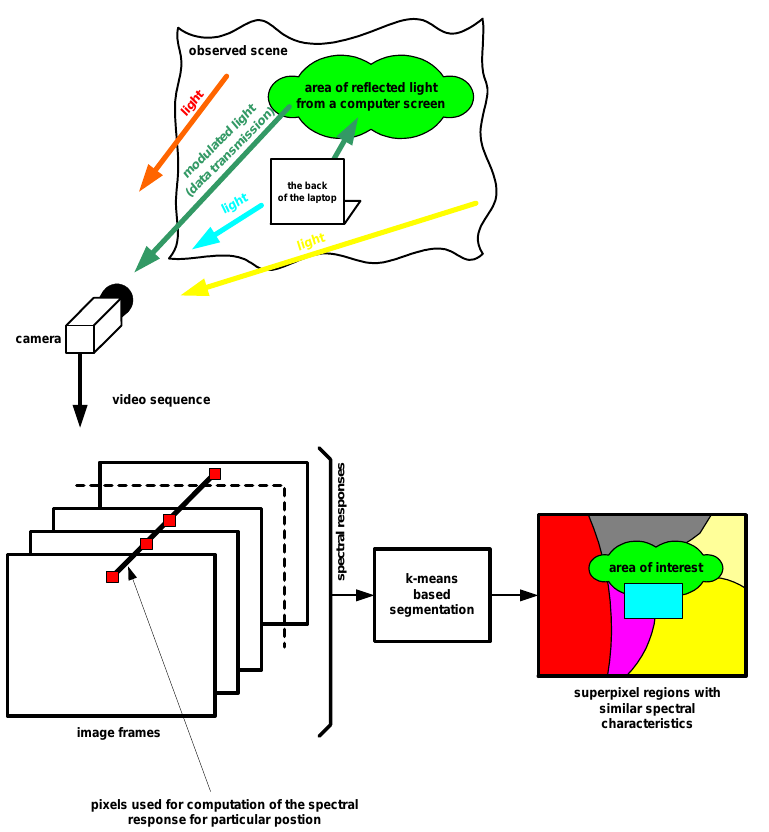
Figure 2. Scheme of the attack using air–gap video transmission using the proposed method. Air gap transmission using the modulated light of a computer screen is difficult to receive in the case of many light sources, for example in a room. In extreme cases, the light from the monitor is not available directly, but only as a reflection from the wall or objects. This means that the recorded video sequence contains a mixture of multiple light